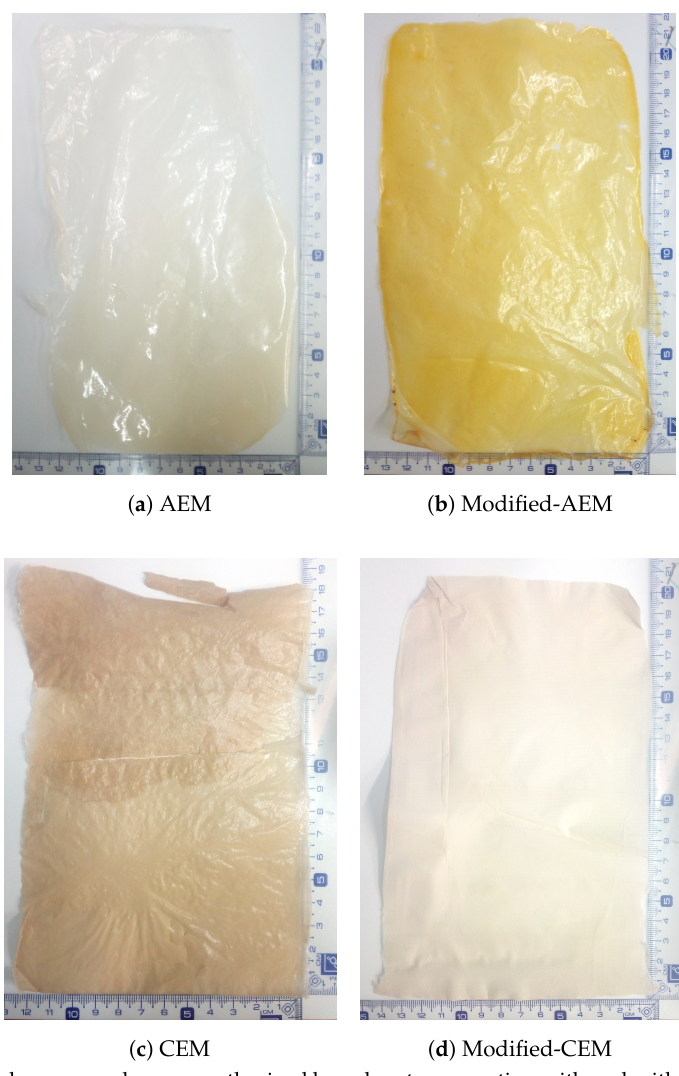
Figure 1. Ion exchange membranes synthesized by solvent evaporation with and without